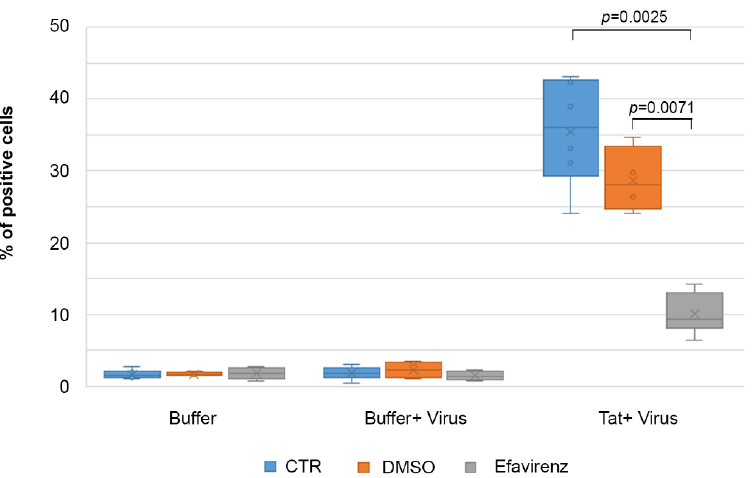
Figure 8. Efavirenz blocks HIV-1 productive infection of IC-HUVEC promoted by extracellular Tat protein. IC-HUVEC were pre-treated with Efavirenz (500 nM) or its resuspension buffer (0.005% DMSO) for 1 h prior to virus infection; then, they were exposed in the presence of the drug to NL4.3 virus (p24-Gag = 70 ng/mL), in the absence or in the presence of 10 μg/mL of biologically active Tat protein (Tat). Four days later, cells were washed, trypsinized, and processed for intracellular staining for p24-Gag antigen. Box-plot of data obtained from three independent experiments and analyzed by the Wilcoxon Two-sample Test are shown. Dots indicate individual measures.